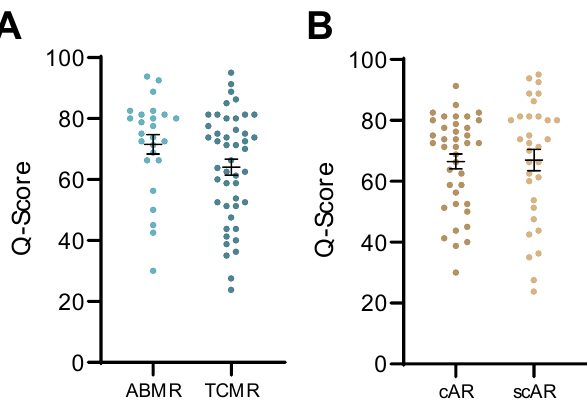
Figure 5. The QSant assay can detect different clinical transplant rejection phenotypes and can detect both clinical and sub-clinical acute rejection. ( A ) The study composed of AR patients with antibody-mediated rejection (ABMR; n = 24) and T-cell-mediated rejection (TCMR; n = 44). No statistically significant difference was observed between two groups, which indicated that Q-Score can effectively detect both rejection phenotypes ( p = 0.076). ( B ) The Q-Score was not significantly different between clinical rejection ( n = 39) and sub-clinical rejection ( n = 32) groups ( p = 0.720).